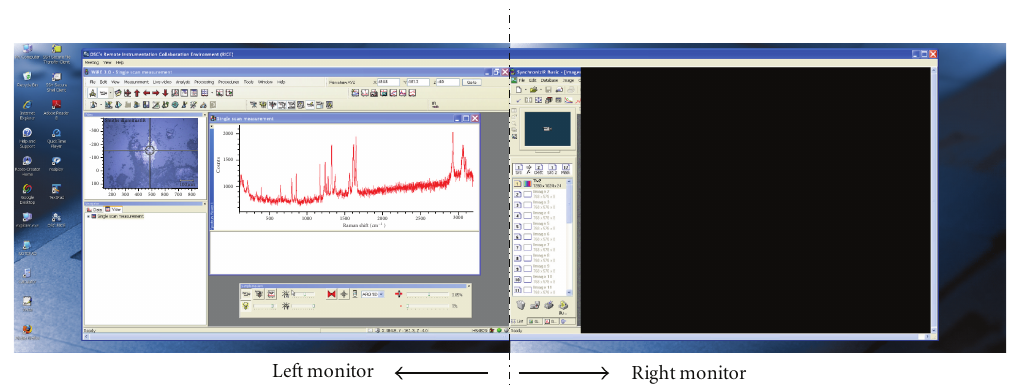
Figure 14: Problem with remote dual-screen resolution with UltraVNC.